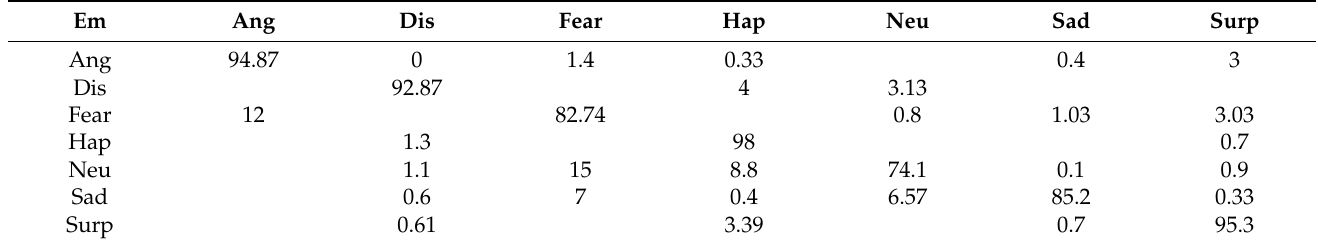
Table 7. Matrix representing the confusions in MMI dataset.